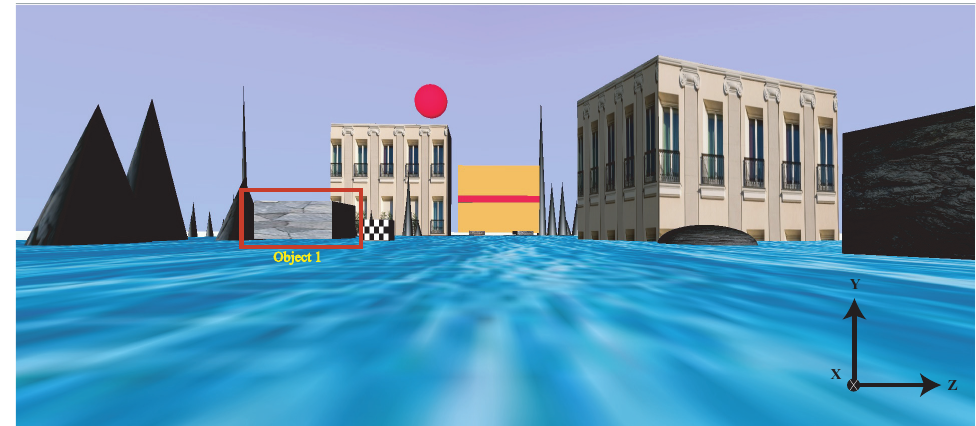
Figure 5. View of the ship’s camera.